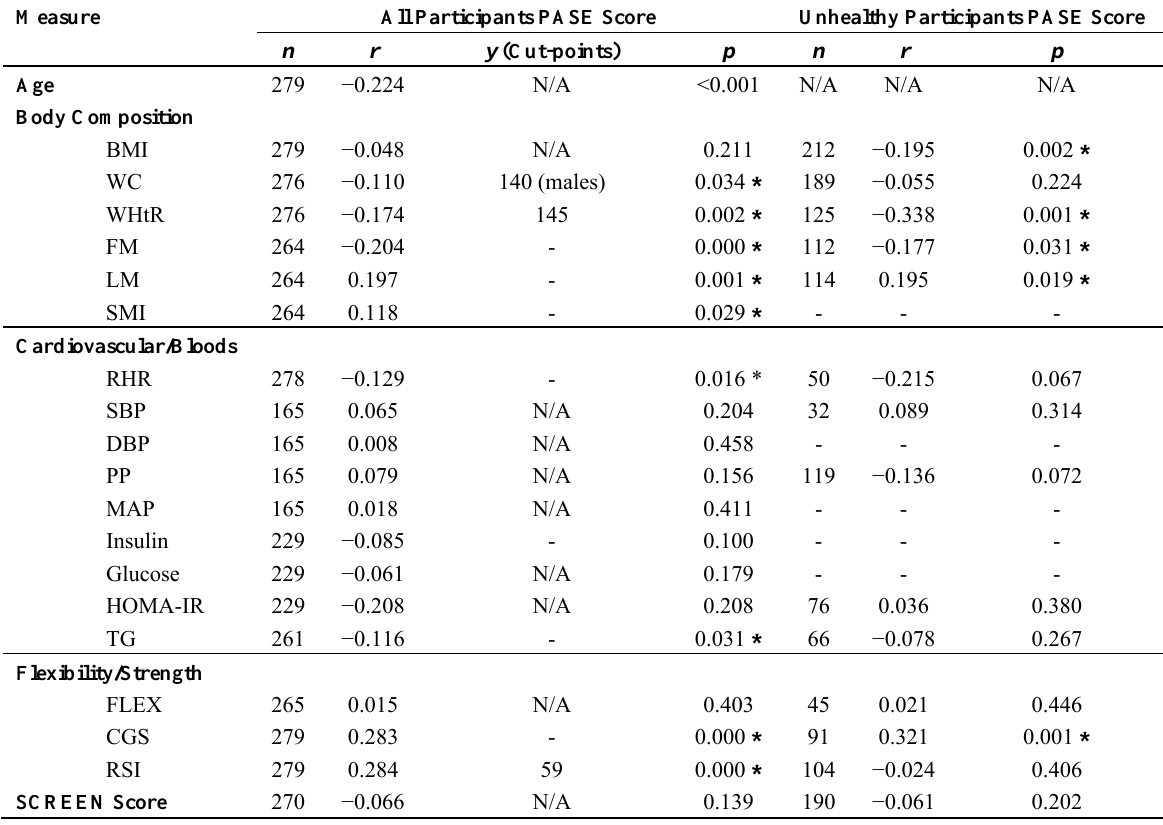
Table 4. Pearson product-moment correlations for all participants and unhealthy participants between body composition, cardiovascular/bloods, flexibility/strength, and SCREEN score measures with PASE